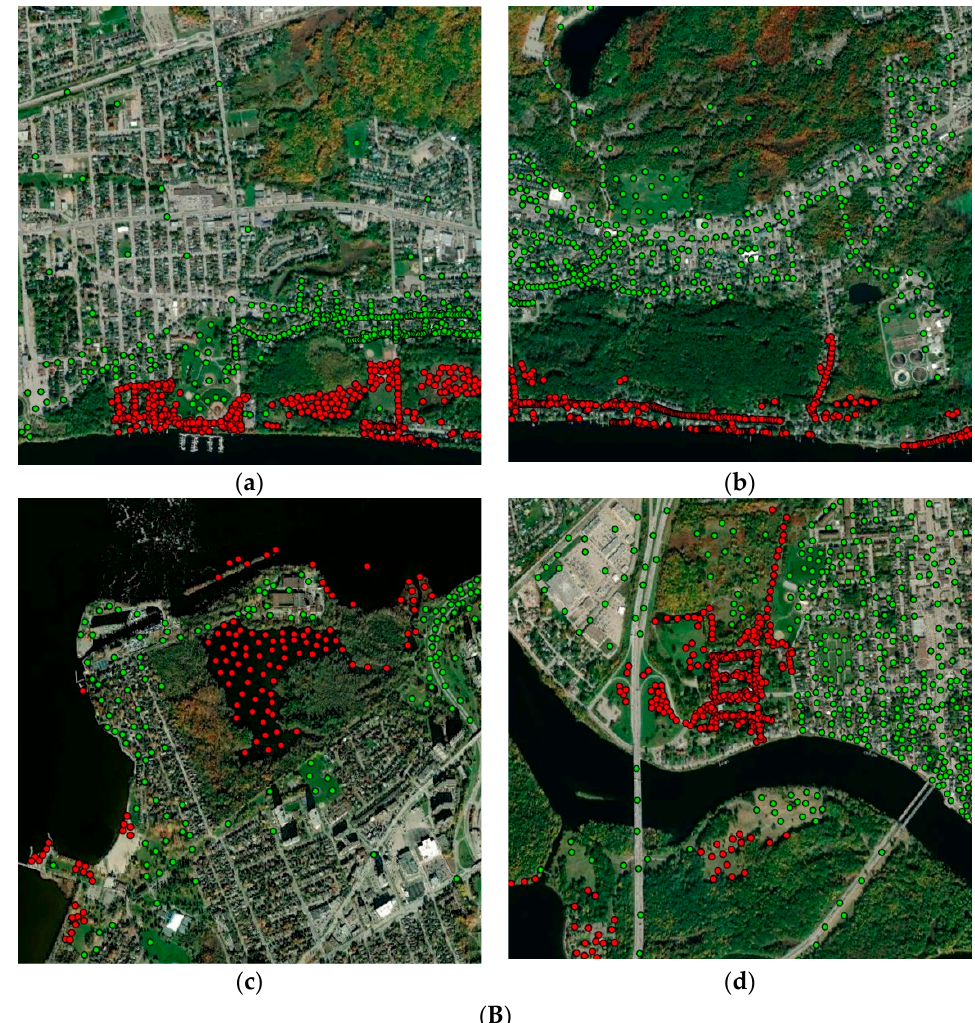
Figure 1. ( A ) an overview map of AOIs ( B ) GCP distribution over four selected AOIs, including ( a ) Area1, ( b ) Area2, ( c ) Area3, and ( d ) Area4. Green circles show non-flooded areas, while red ones indicate flooded areas.